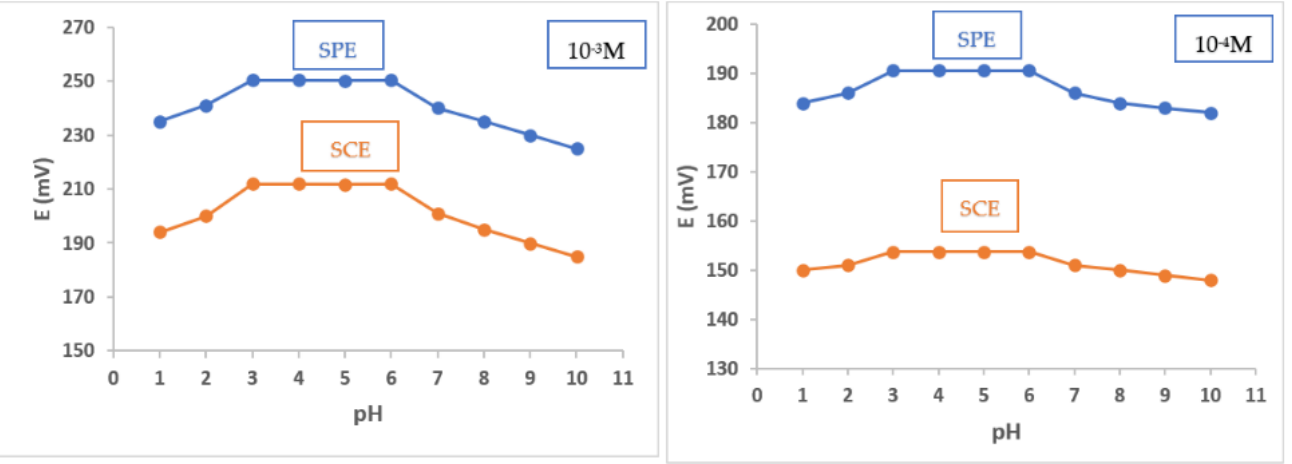
Figure 4. pH effect on the potential response of the fabricated electrodes using 1.0 × 10 −3 M and 1.0 × 10 −4 M BRZ standard solutions. 1.0 × 10 − 4 M BRZ standard solutions.